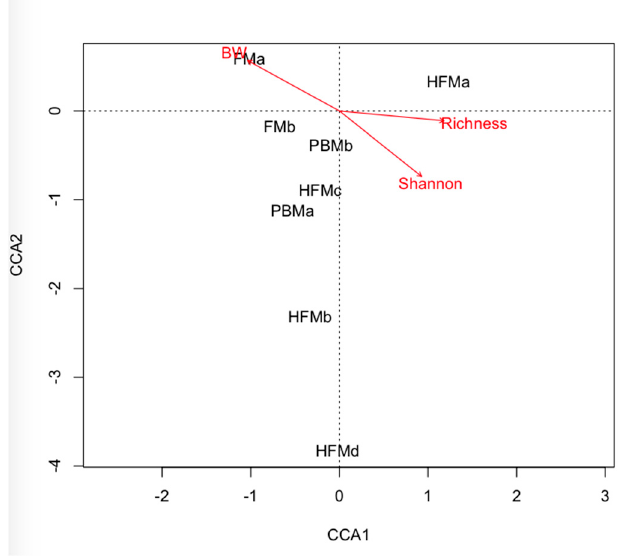
Figure 6. Canonical correspondence analysis for fish fed the FM, PBM50 and HFM50 diets. Only factors with significant values ( p < 0.05) are presented.